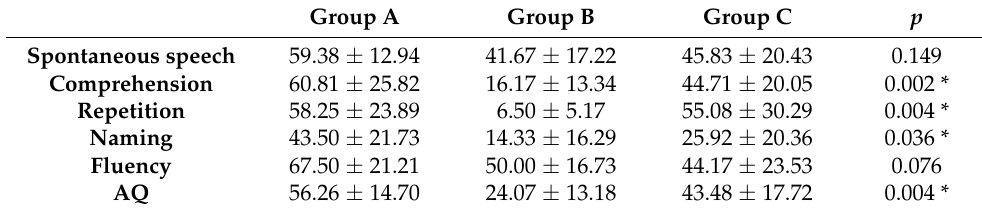
Table 4. The results of the WAB subsets # .